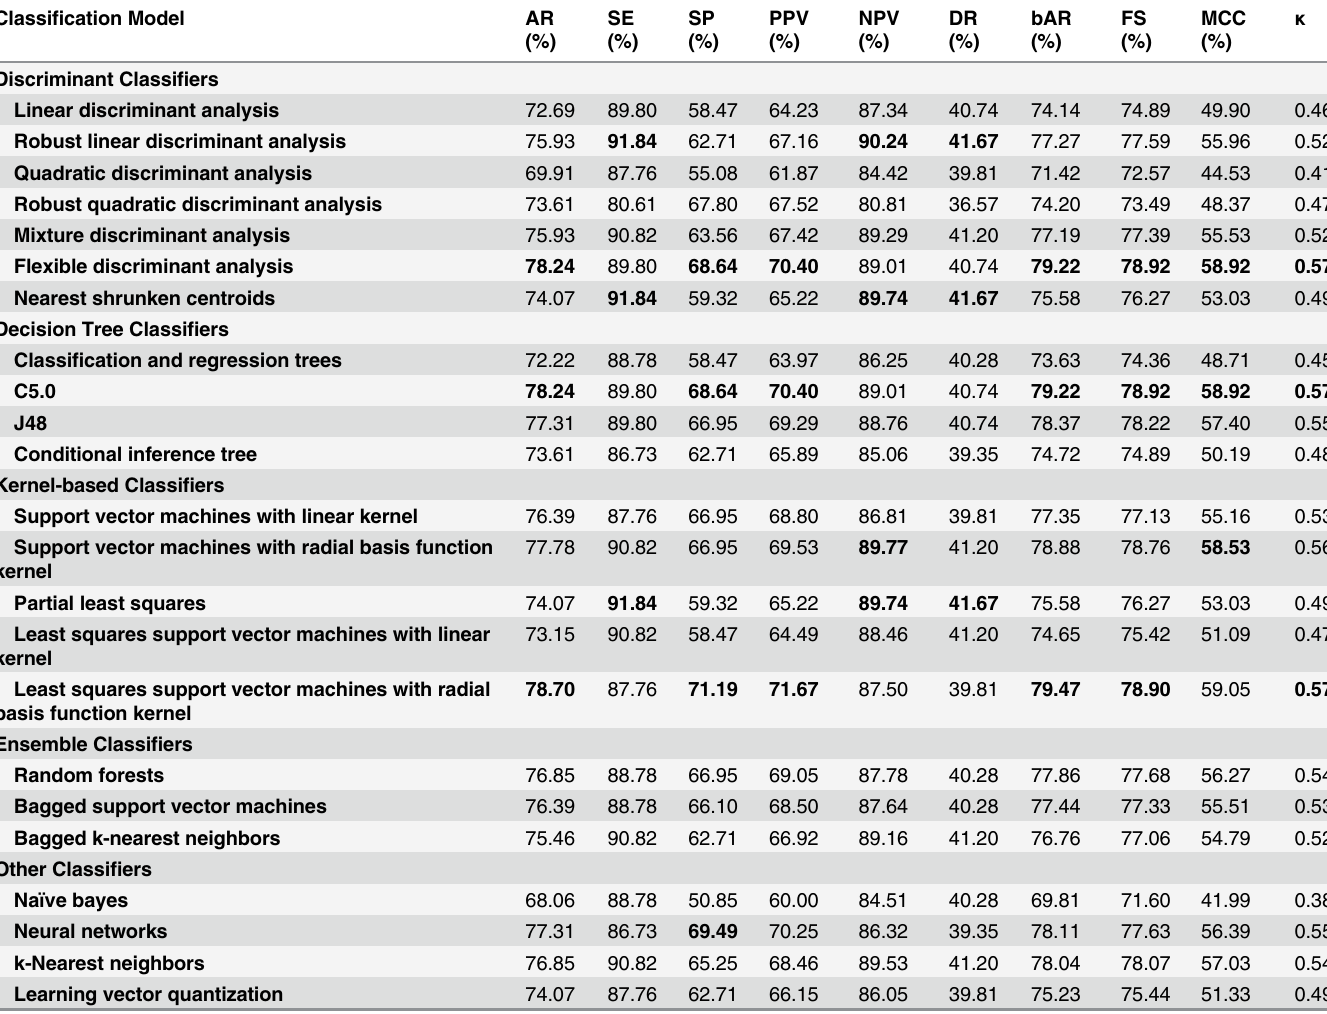
Table 1. Performance assessment of various statistical learning algorithms in virtual screening of